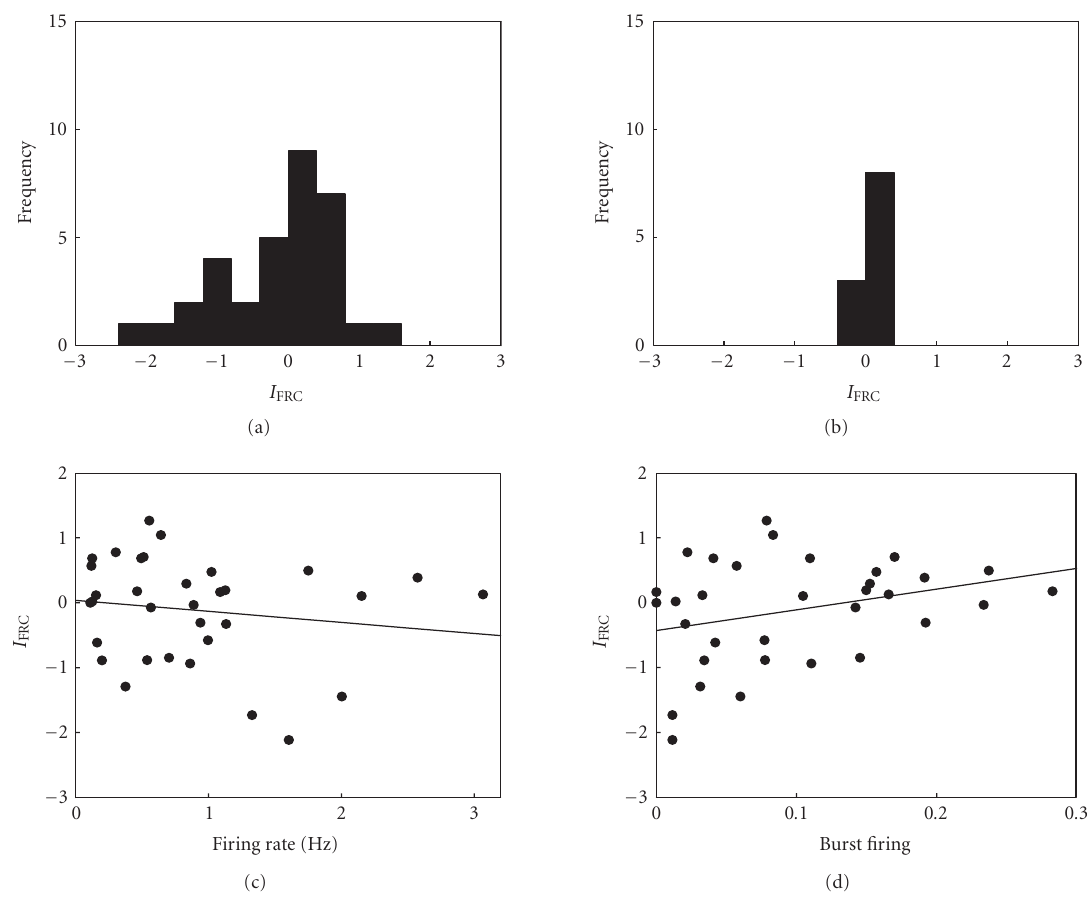
Figure 3: MA e ff ects in anesthetized animals. (a)-(b) The frequency histograms show the distribution of I FRC ( z -transformed values) follow- ing MA (a) or vehicle (b) injection. Positive (or negative) numbers along the abscissa denote enhanced (or reduced) discharge rate following MA injection. (c)-(d) The relationship between I FRC ( z -transformed) and average firing rate (c) or burst firing (d) during the baseline period. The lines were obtained by linear regression. None were